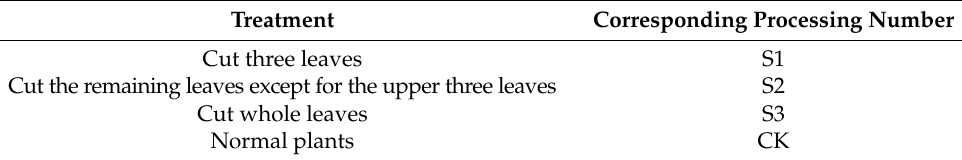
Table 2. Field treatment and corresponding